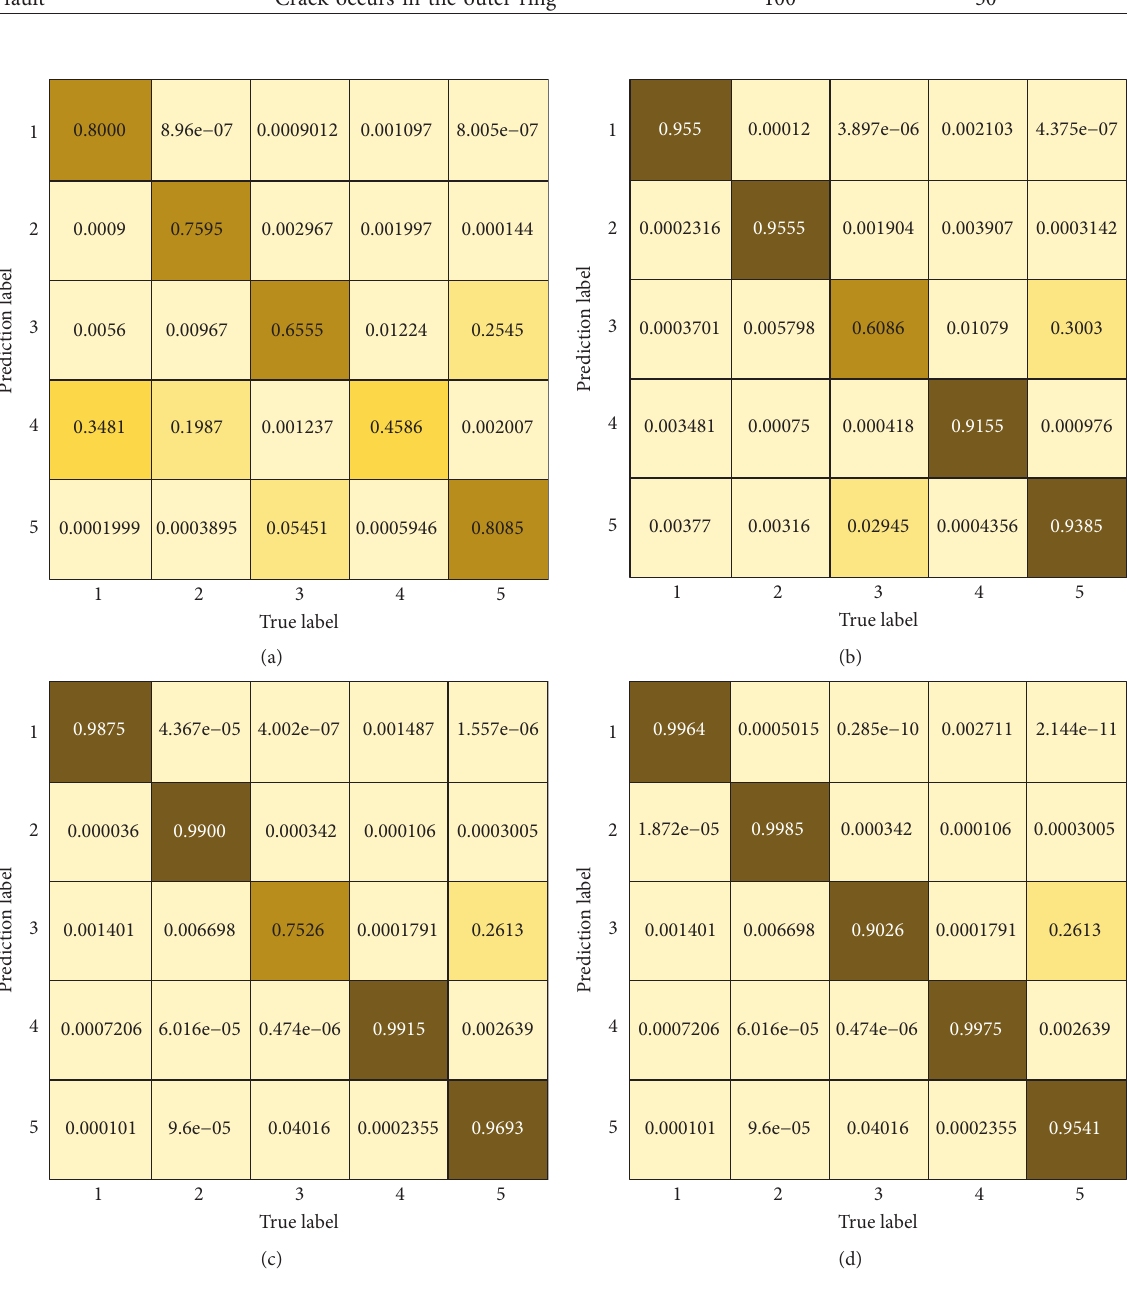
Figure 14: Confusion matrix of the detection results. (a) BPNN. (b) Non-opt DBN. (c) PSO-DBN. (d)